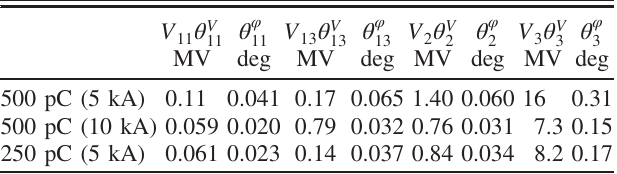
TABLE VI. The rf tolerances for 10% change of the global compression.